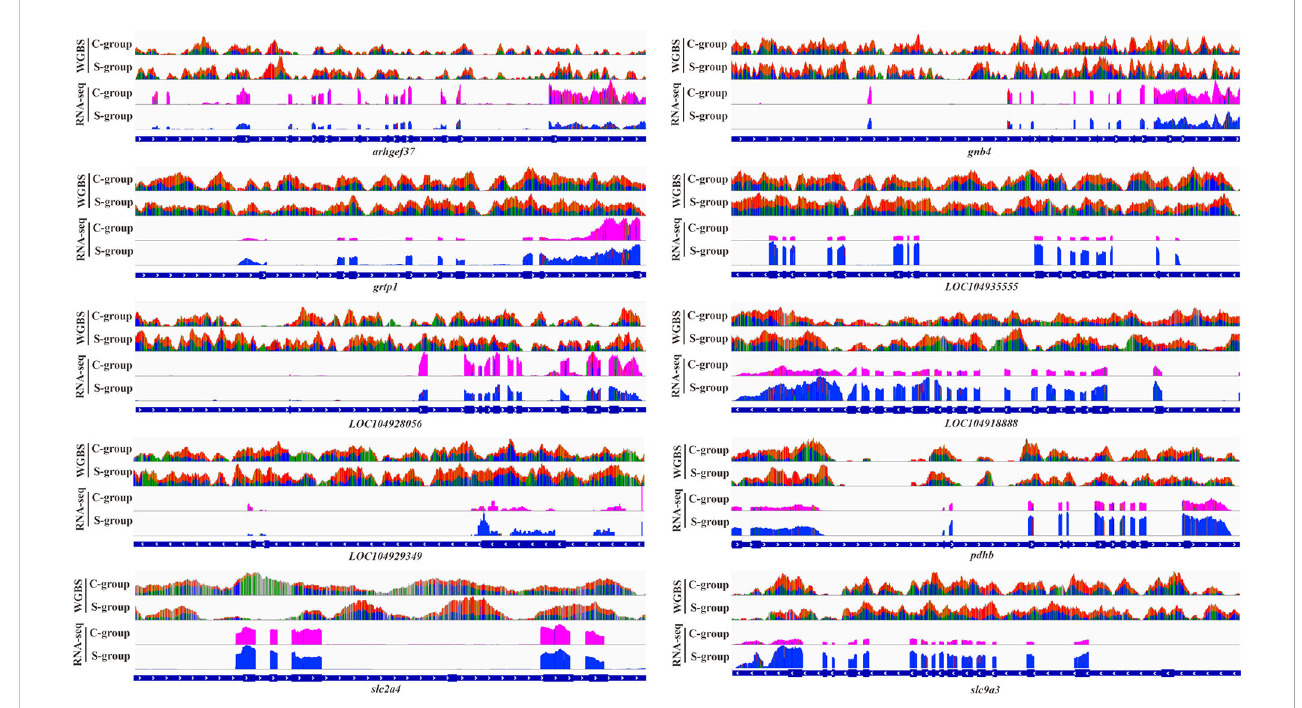
FIGURE 8 Genome browser tracks showing the correlation between promoter methylation status and gene